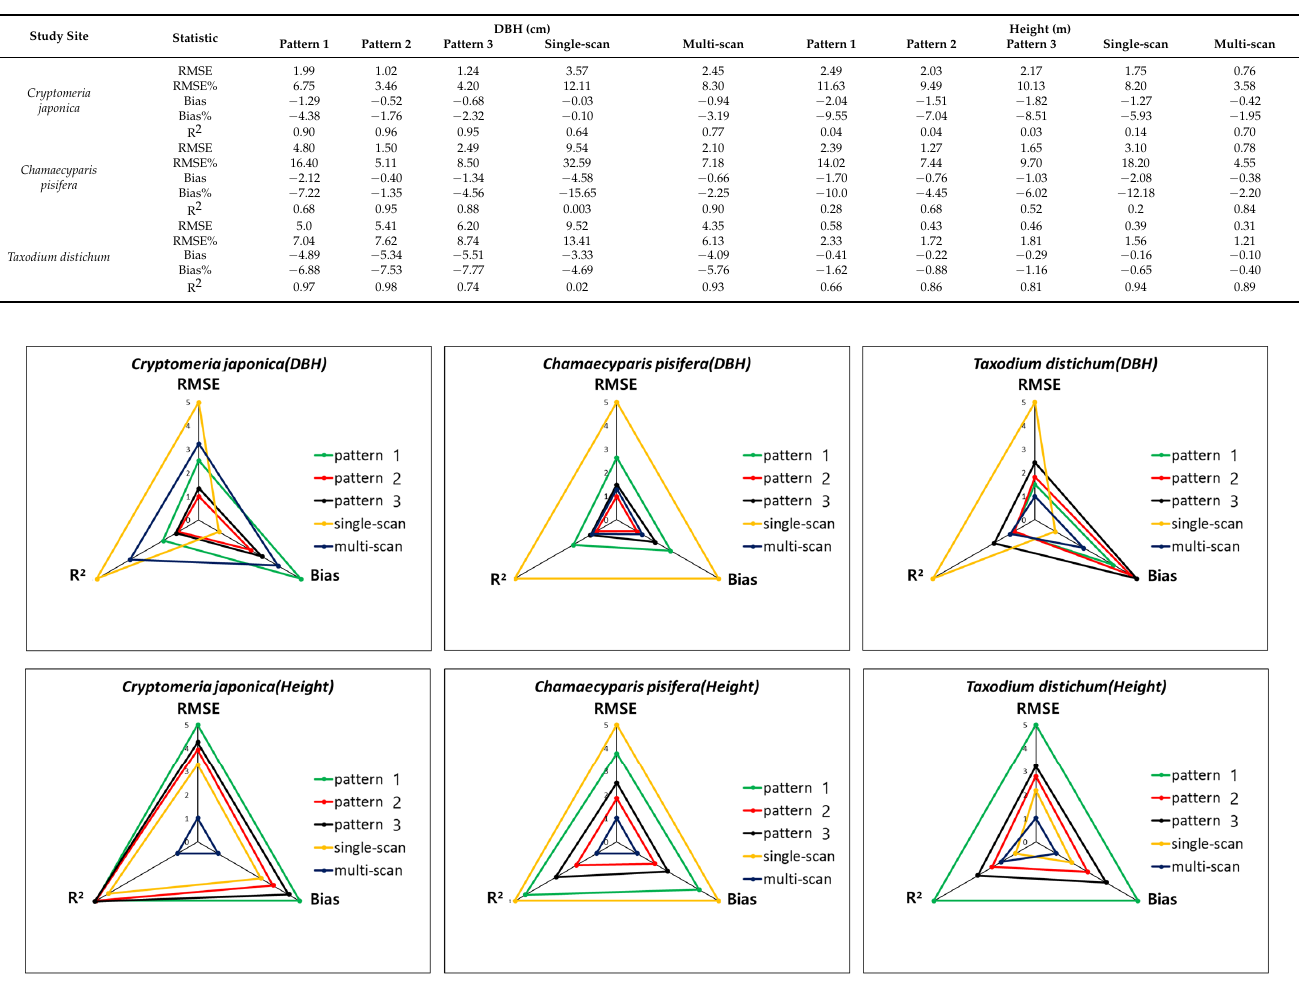
Figure 7. Rankings by statistical accuracy. The results from the three plots show that the goodness of fit for DBH was larger for the BPLS than for the TLS, and the largest goodness of fit was found using Patterns 2 and 3. Additionally, the TLS multi-scan method showed a higher level of accuracy but a lower level of goodness of fit for the Cryptomeria japonica plot than for the other plots. A comparison of the differences between the three plots showed that the least accurate results were achieved in the Chamaecyparis pisifera plot because of its characteristics. The plot had more vegetation at around 1.2 m, which is the height up to which the stem is scanned to estimate DBH. Consequently, the targets were hidden, and this inhibited point cloud collection and reduced the accuracy of the